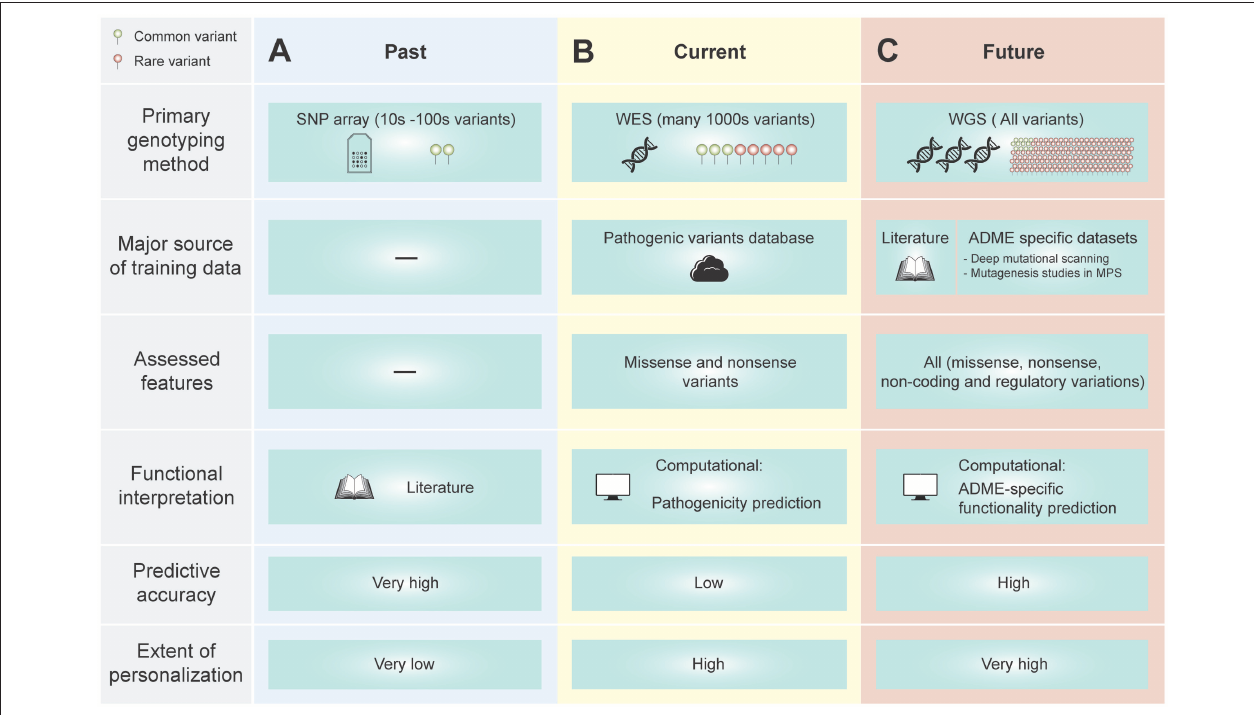
FIGURE 2 | The past, present and future of pharmacogenetic phenotype predictions. (A) Conventionally, pharmacogenetic predictions were based on the interrogation of few common candidate SNPs, whose functional effects were predicted based on extensive literature evidence, resulting in high predictive accuracy but only few considered variations. (B) With increasing prevalence of whole exome sequencing (WES), a multitude of pharmacogenetic variants with unknown functional relevance are identified. These variants can be interpreted using computational methods. However, current algorithms are generally trained to detect the pathogenicity rather than the functionality of queried variants, resulting in overall relatively low predictive accuracy. Furthermore, only effects of missense and nonsense variants are evaluated. (C) In the near future, whole genome sequencing (WGS) will become the predominant genotyping methodology, revealing not only coding variants but also variants in regulatory regions and introns. To facilitate interpretation of this data, we envision that pharmacogenetic predictors will be directly trained on functionally annotated ADME data sets. Emerging technologies, such as deep mutational scanning for the systematic interrogation of missense variants or mutagenesis screens in microphysiological systems (MPS) for the characterization of variants in regulatory regions, provide powerful tools to generate these data, boosting the predictive performance of data hungry machine learning tools. These advances allow to go beyond the interpretation of missense and nonsense variants and to include also non-coding and regulatory variations into pharmacogenetic